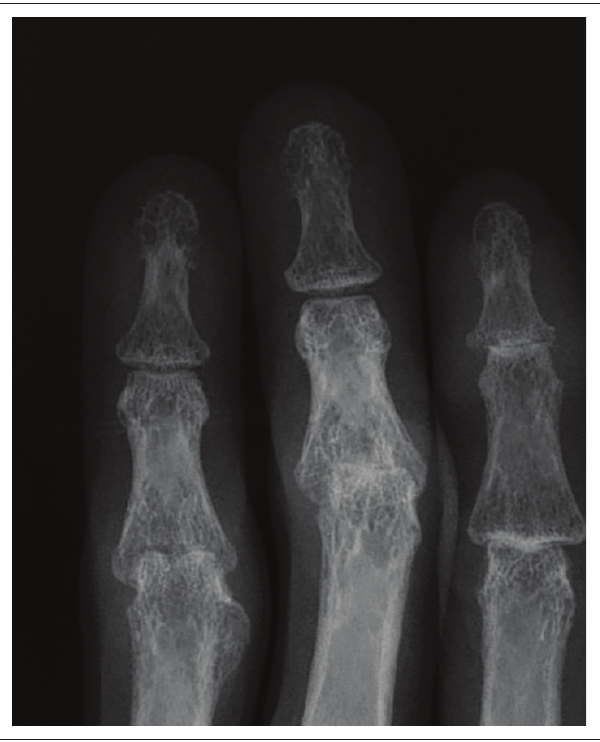
FIGURE 3: Magnified view of the phalanges of the left 2nd, 3rd and 4th phalanges of the left hand of the patient discussed in Figure 1, demonstrating new bone formation of the proximal phalanx of the 4th finger and more clearly demonstrates the subluxations at the 3rd and 4th proximal interphalangeal